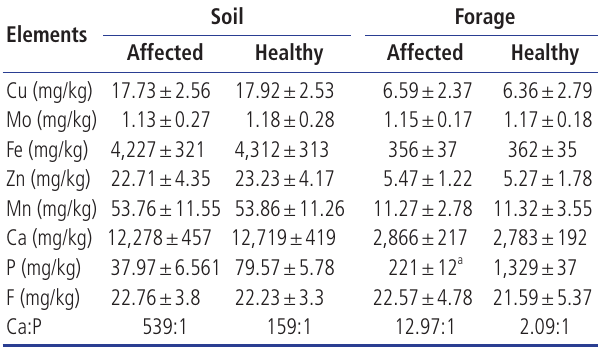
Table 2. Biochemical parameters in Qianbei-Pockmarked goats Blood parameters